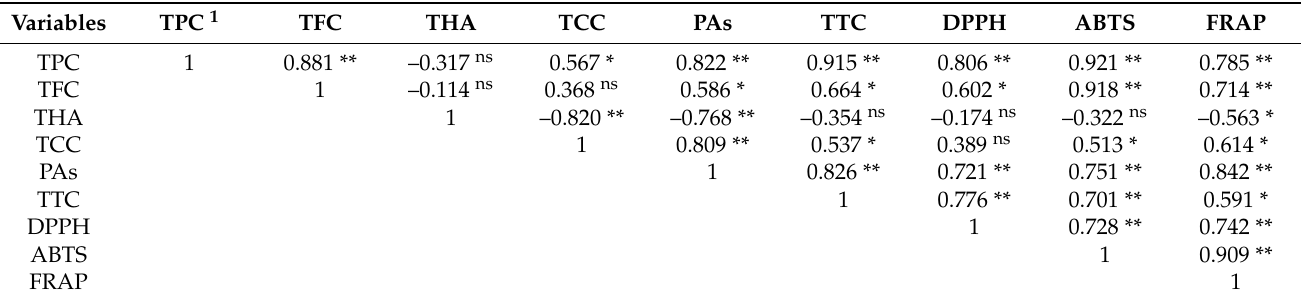
Table 4. Correlation matrix with the Pearson coefficient values for phenolic compounds and antioxi- dant activity of Rumex extracts.